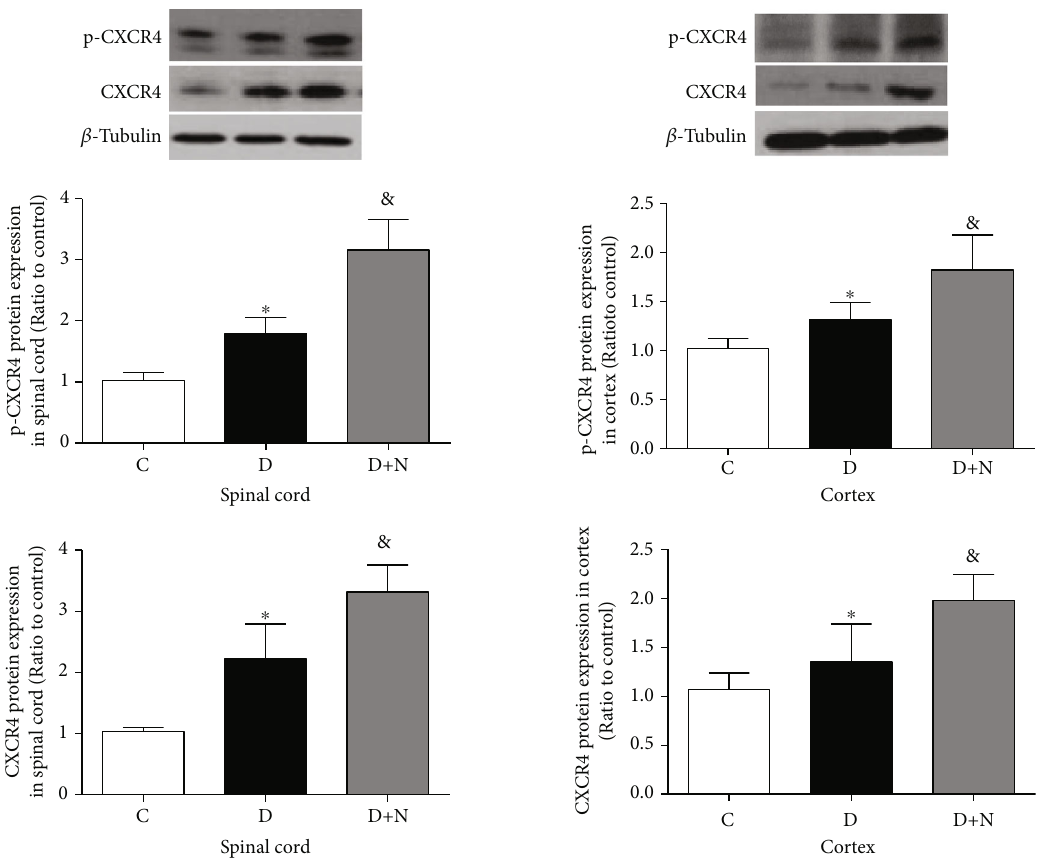
Figure 5: E ff ect of three weeks of NAC treatment on change in expression of CXCR4 and p-CXCR4 in the spinal cord and prefrontal cortex of diabetic rats measured by western blotting analysis. All results are presented as means ± SD , n = 6 /group; ∗ P < 0 : 05 (D vs. C), & P < 0 : 05 (D+N vs. D).